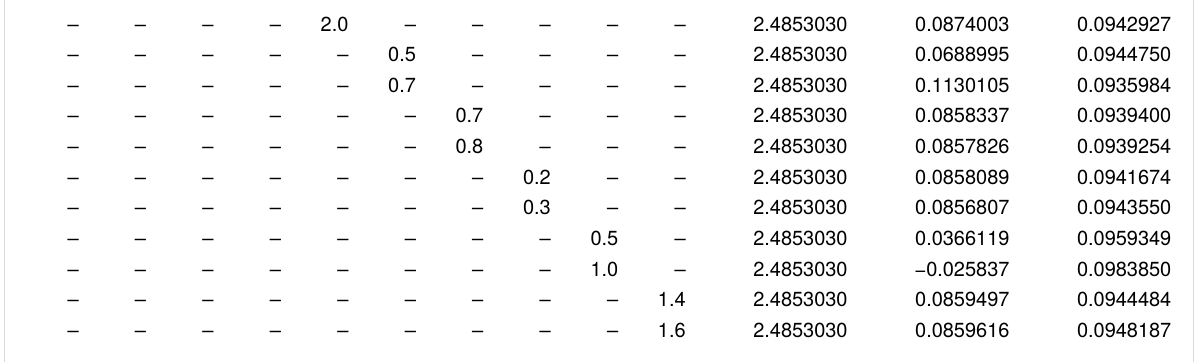
Table 4: The computed results for the skin-friction coefficient, Nusselt and Sherwood numbers, for γ = 1, Bi 1 = 0.1 = Bi 2, where a 1 = (1 + 1/ β ) and a 2 = (1 + 4/3· R ). (continued)